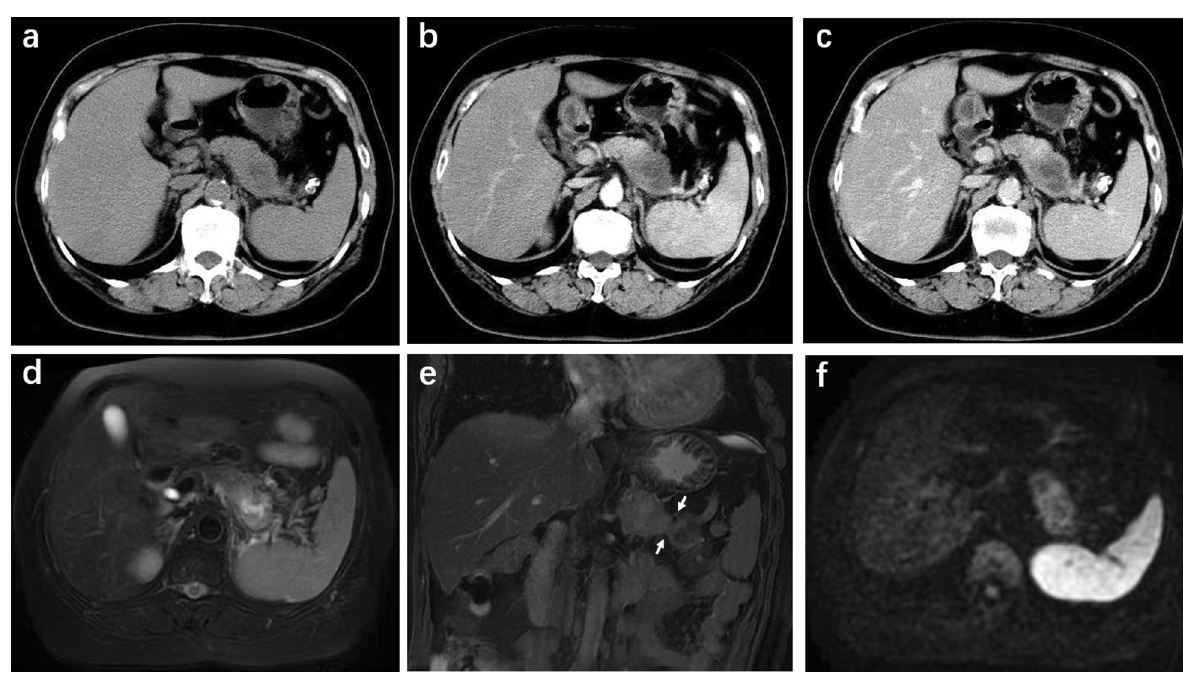
Fig. 1 MiNEN of the pancreatic tail in a 63-year-old woman. a Unenhanced CT scan shows an ill-defined mass with a size of 8.0 cm. The CT value of the tumor is 39 HU. b Arterial phase CT scan shows peripheral moderate enhancement of the mixed solid and cystic lesion. The CT value of the tumor is 67 HU. c Portal phase CT scan shows heterogeneous enhancement with a central fill-in appearance. The CT value of the tumor is 75 HU. d Fat suppressed T2-weighted axial MR image indicates the hyperintense mass with significantly higher signal inside the lesion which was proven to be necrosis on histopathology. e Coronal fat suppressed 2D-FIESTA image shows a blurred interface between the tumor and the adjacent colon (arrows) which indicates that the fat filled gap disappears and the tumor infiltrates into surrounding intestinal wall. It is one typical sign of adjacent colon invasion which was confirmed by pathological results. f Diffusion-weighted MR image reveals relative hyperintense tumor indicating restricted diffusion